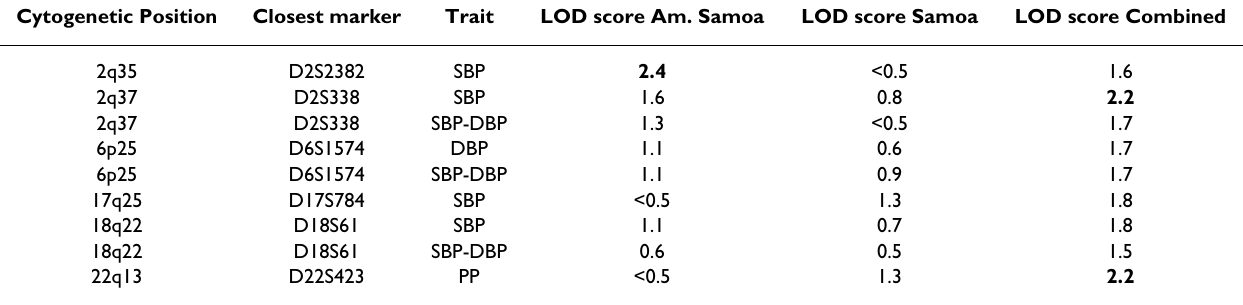
Bold indicate suggestive linkage (LOD score 